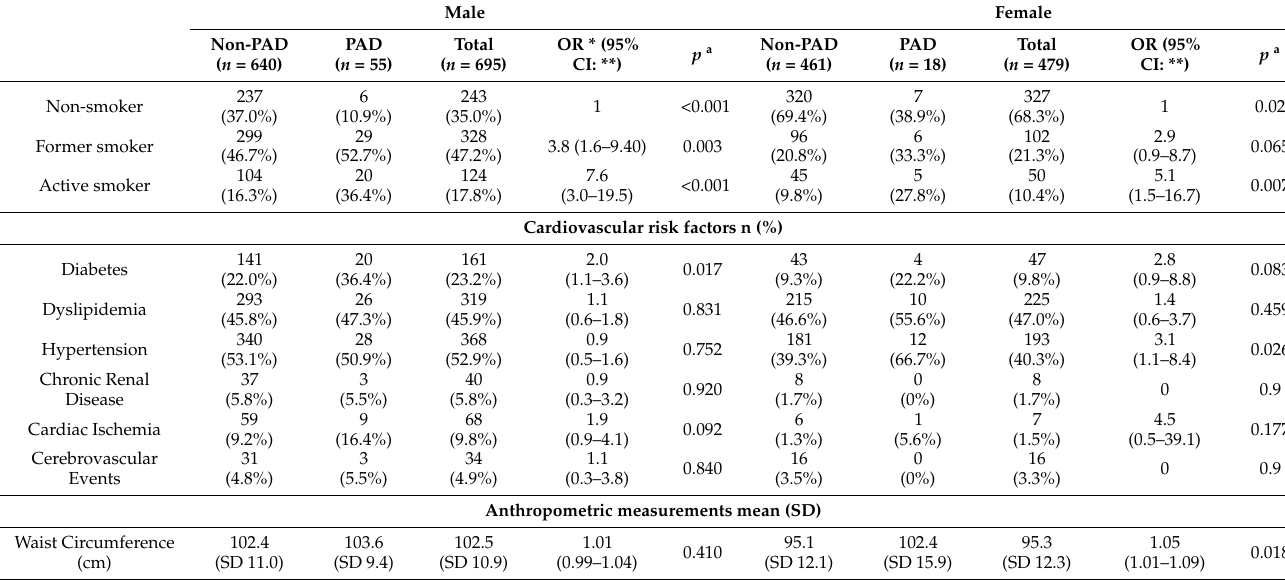
Table 1. Relationship between PAD and risk factors divided by gender. Logistic regression model with OR and CI 95% of the potential variables associated with PAD.